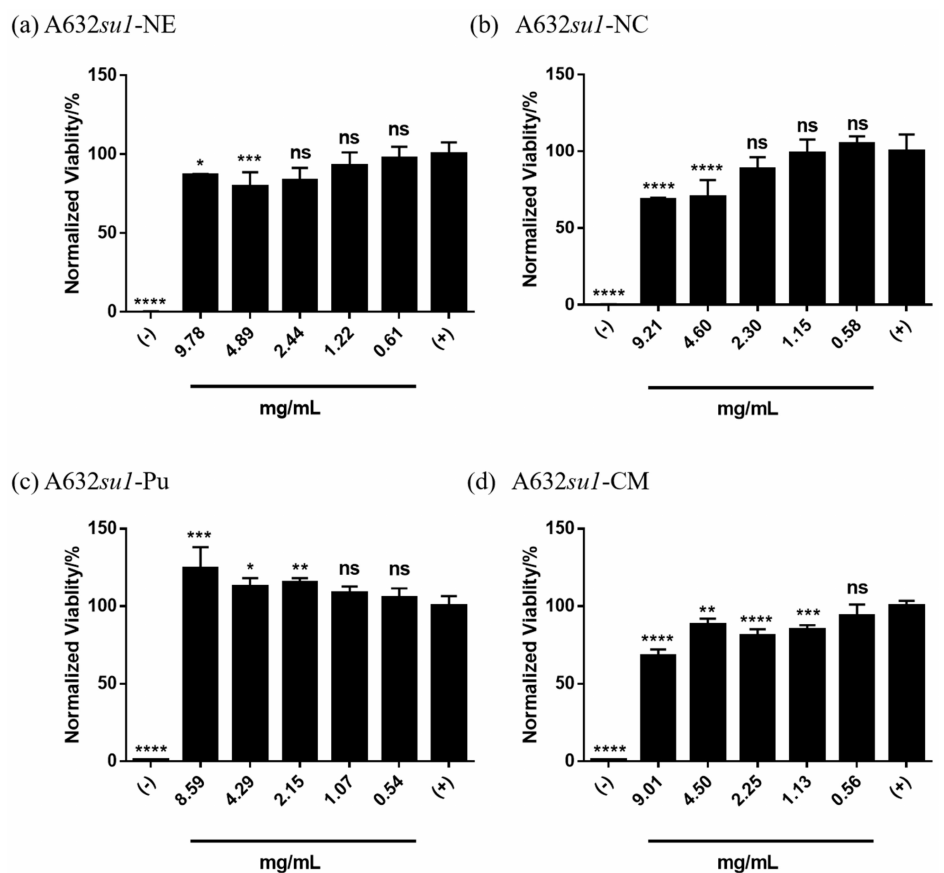
Figure 4. Cytotoxicity of extracts from the same plant with di ff erent su1 mutants. Phytoglycogen was extracted from all plants using ethanol precipitation. Cells were treated with 50 v / v % PBS (positive control) or 50 v / v % DMSO (negative control). Data are presented as mean ± standard deviation ( n = 5). * indicates statistically significant di ff erences compared to the positive control group; “ns” indicates no di ff erence relative to the positive control group at t = 24 h. Statistical significance was calculated using a one-way ANOVA followed by Tukey’s post-hoc. * p < 0.05, ** p < 0.01, *** p < 0.001 and **** p < 0.0001.